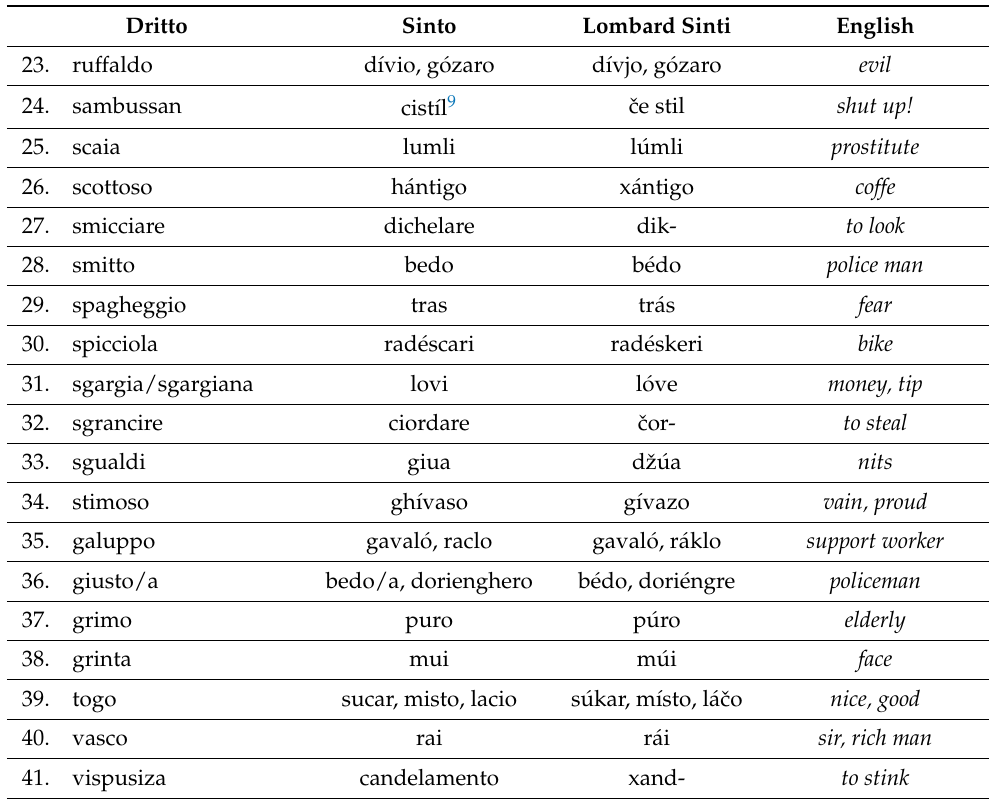
Table 1. Cont. Dritto Sinto Lombard Sinti